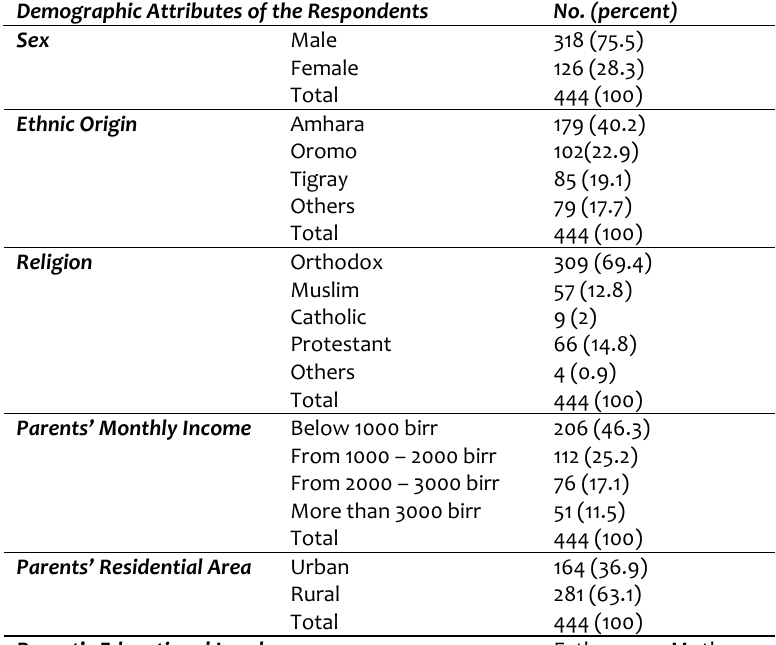
Table 1: Demographic Data of